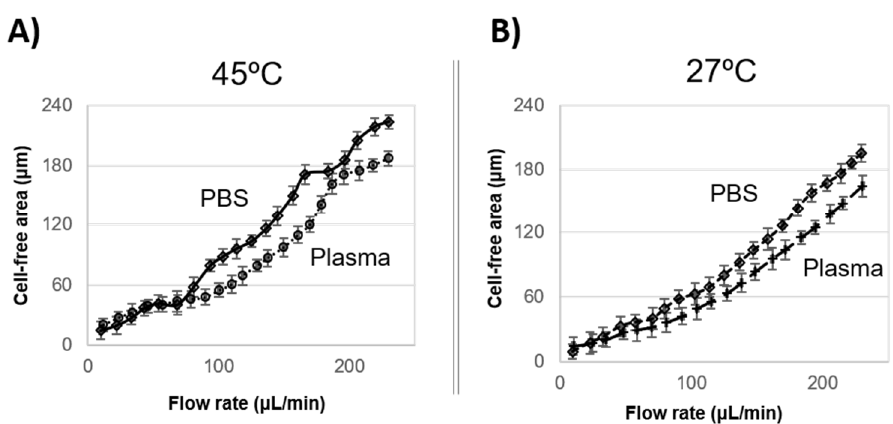
Figure 6. Plot of cell-free area (CFA) responds to flow rate increment at ( A ) 45 ◦ C and ( B ) 27 ◦ C. Analyzing deformable particle suspension in inertial flow at low capillary numbers, Chiara, FL et al. (2020) found that particles are more sensitive to shear rate variations, which is more remarked as particle concentration increases [33]. The interaction between particles increases their shape deformability and the channel’s central core concentration due to particle migration. On the other hand, rigid particles occupied a larger traversal area, decreasing the particles-free area near the channel wall.